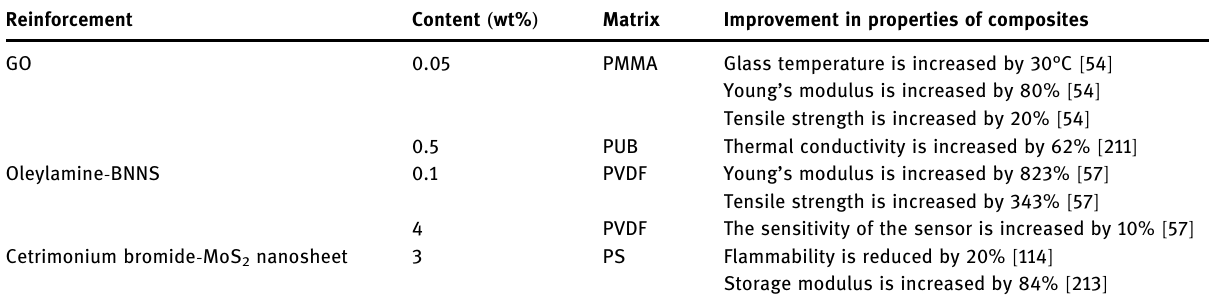
Table 4: Improvement of functionalized 2D nanomaterials in the properties of polymer composites Reinforcement Content ( wt% ) Matrix Improvement in properties of composites